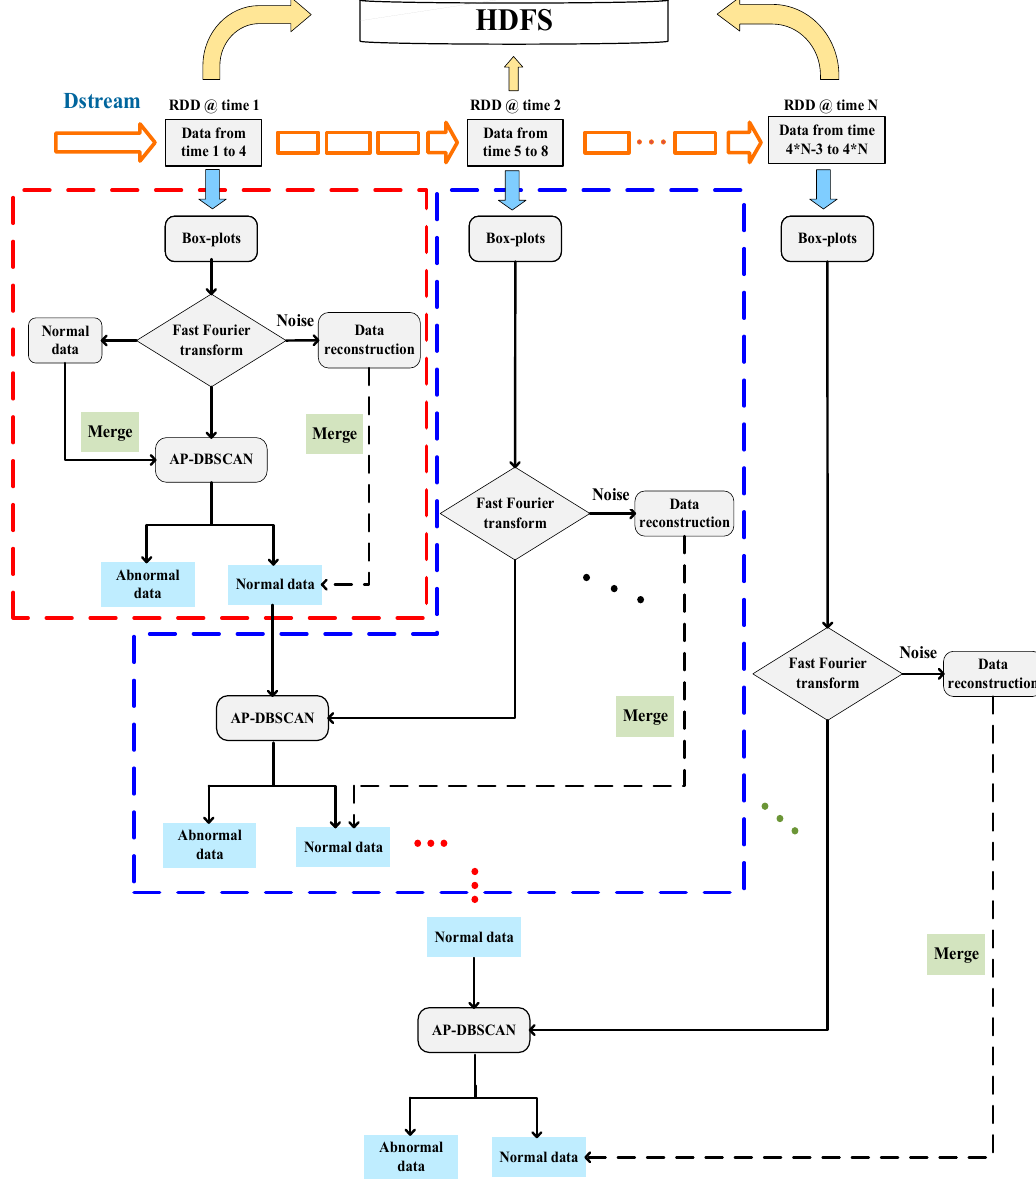
Figure 2. The workflows of AP-DBSCAN implementation on Spark Streaming.